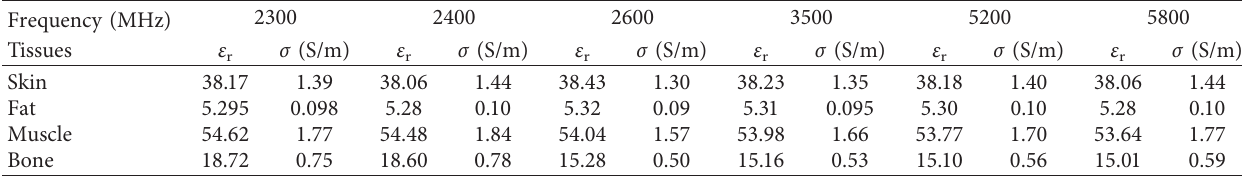
Figure 15: SAR simulation setup. Table 4: Human hand tissues characteristics [15].